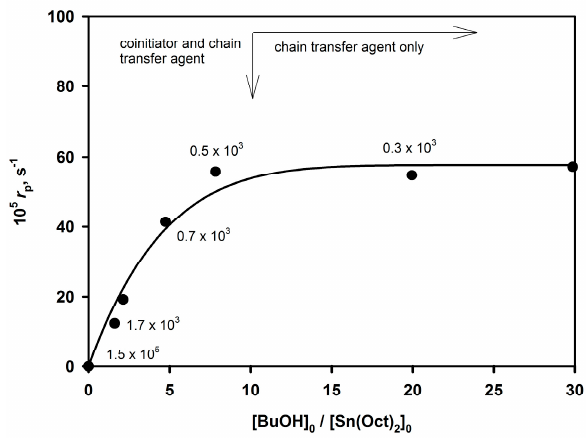
Figure 5. Dependence of the rate of polymerization of L -Lacide (LA) (( r p = ln{([LA] 0 − [LA] eq )/([LA] − [LA] eq )/ t ) on [ n- BOH] 0 ) at constant concentration of Sn(Oct) 2 = 0.05 mol·L − 1 . Polymerization at 50 °C, in THF solvent. The numbers on the plot relate to M n values [46].